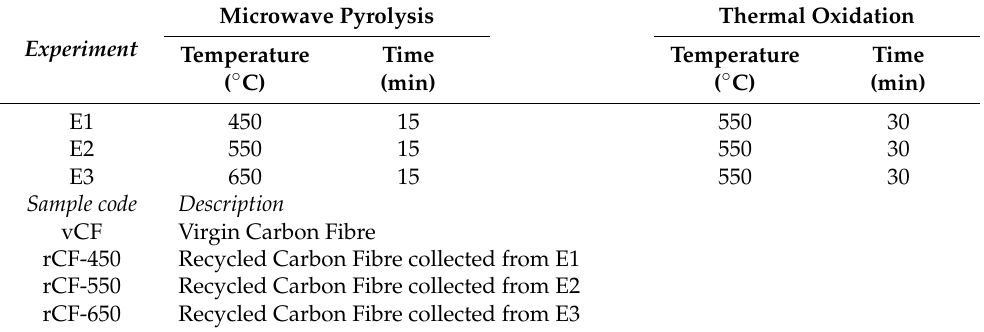
Figure 1. The experimental setup for the microwave pyrolysis system. Table 1. Experiment schema and test sample